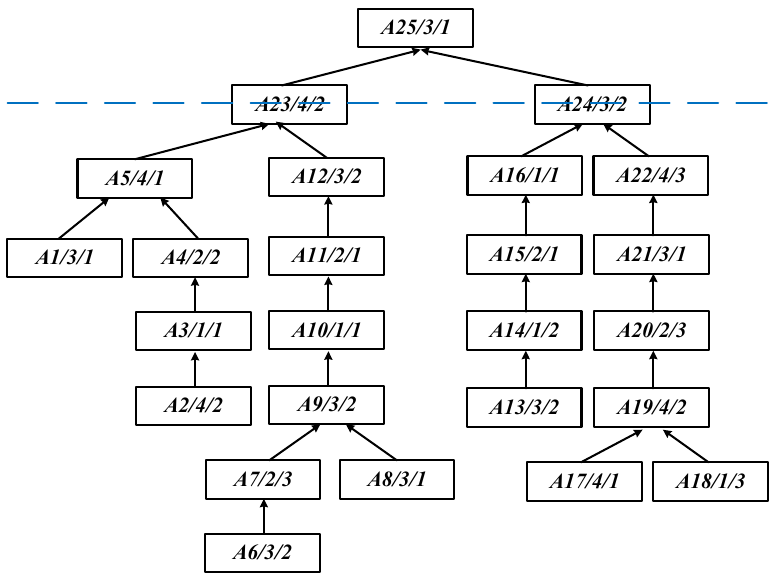
Figure 1. Processing tree of complex product A .